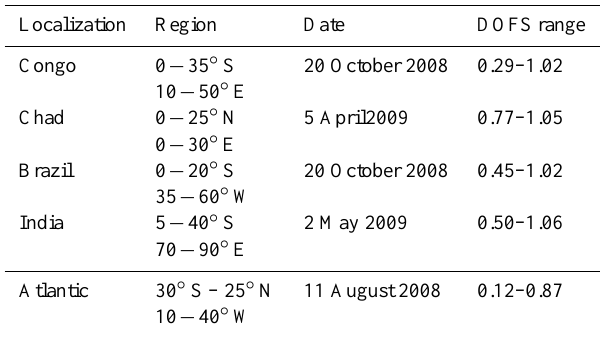
Fig. 2. Top panel: Illustration of the two CH 3 OH a priori profiles (continental and oceanic) derived from the IMAGESv2 CTM model for the year 2007. Open circles represent the a priori on the 4 layers retrieval grid. Bottom panels: Plot (expressed in %) of the associ- ated covariance matrices (left: for land, right: for ocean). Table 1. Selected regions and periods for the retrieval of methanol using the Optimal Estimation